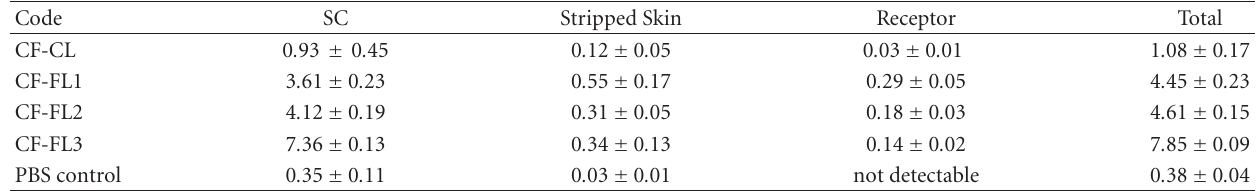
Table 2: Amounts of CF (expressed as cumulative % of dose applied, n = 3) in the di ff erent layers of rat skin after 6 hours of nonocclusive